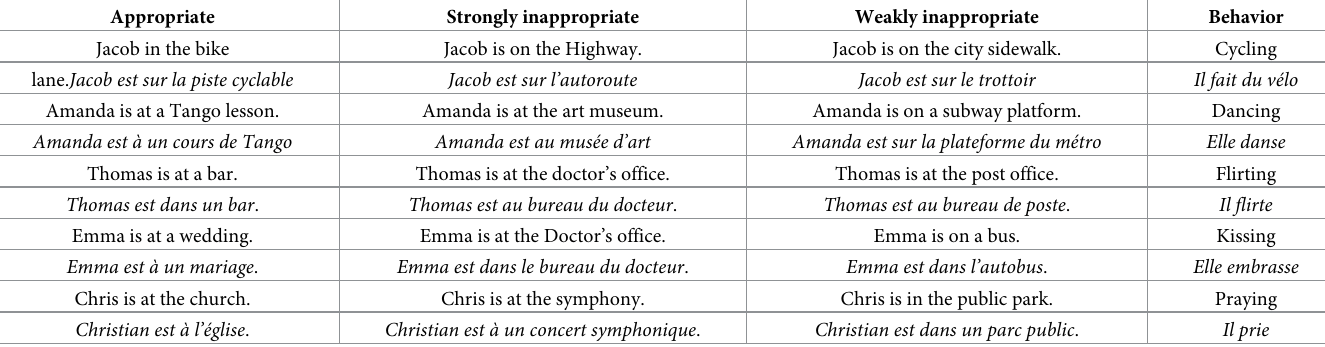
Table 2. Scenarios example. 5 behaviors with their 3 associate conditions and the French